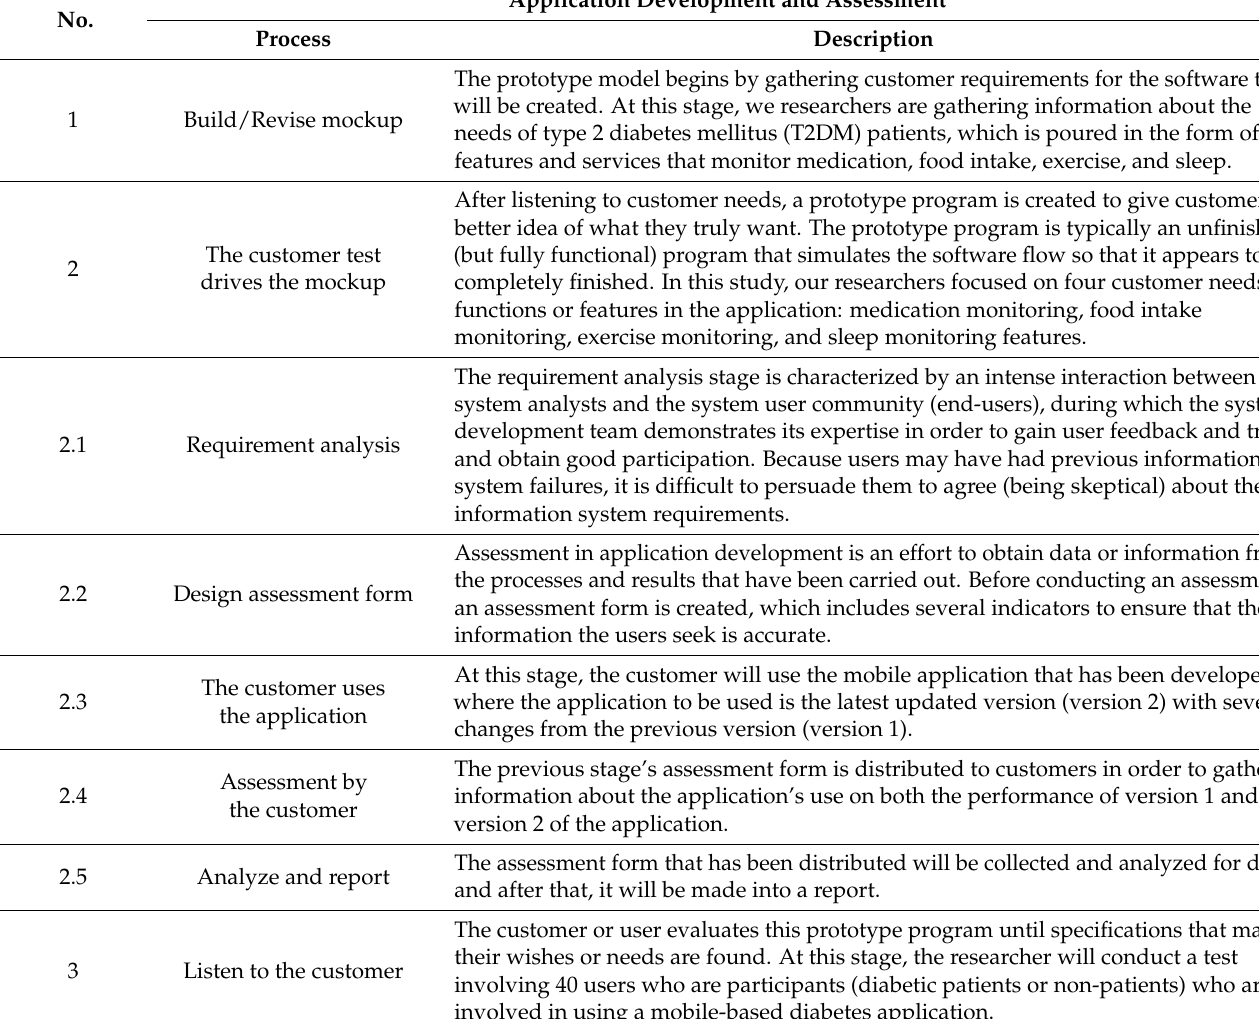
Table 6. Application Development and